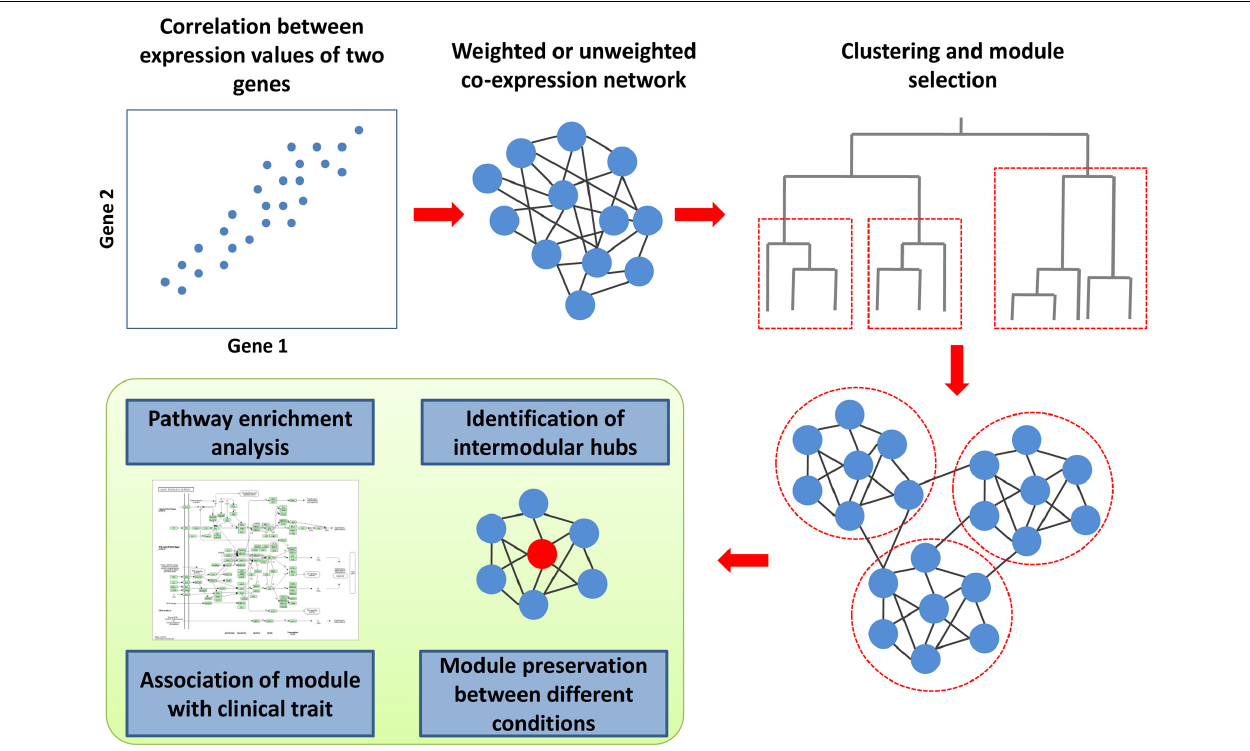
FIGURE 4 | Co-expression analysis framework. To determine co-expression, the correlation between expression values for all gene pairs must be calculated. The weighted or unweighted co-expression networks can be created based on these values. A cluster analysis, which is based on co-expression values, allows identifying modules (clusters) of co-expressed genes. The co-expression module contains genes that could be regulated by the same transcription factors and have similar biological functions. The genes from each module can be used for pathway and Gene Ontology enrichment analysis to identify corresponding biological functions. Weighted gene correlation network analysis (WGCNA) is the most popular framework for the creation of co-expression networks. Along with the identification of modules, it can be used to estimate module preservation between two networks created for different conditions, reveal modules associated with a clinical trait of interest and find intermodular “hubs,” which could be the essential genes regulating the expression of the other genes in the